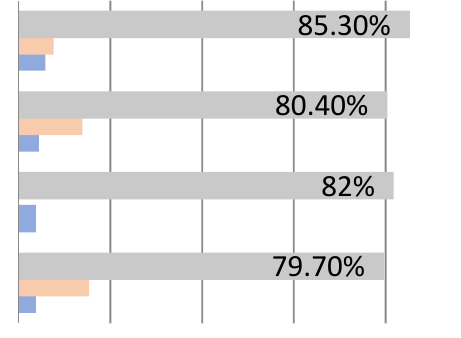
Figure 1. What judgments do you have about these problems?